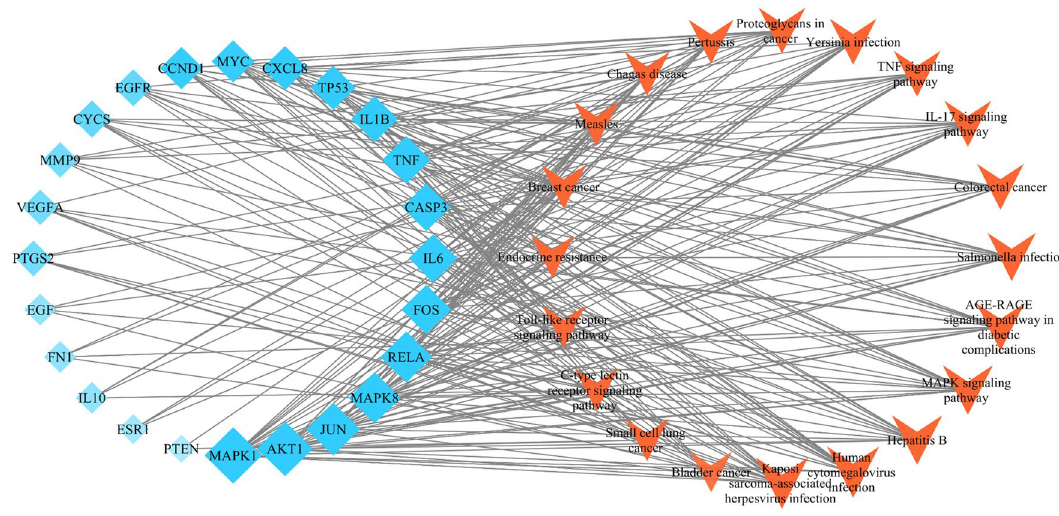
Figure 8. The targets-pathway network of BSTZC for treating HLP.